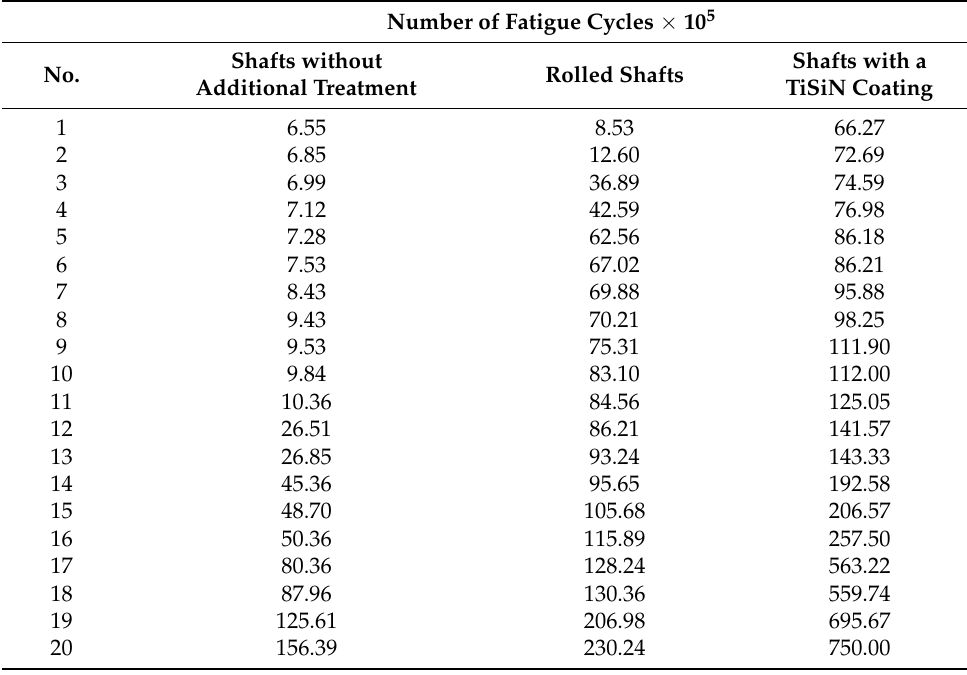
Table 4. Number of fatigue samples at which damage symptoms were noted.